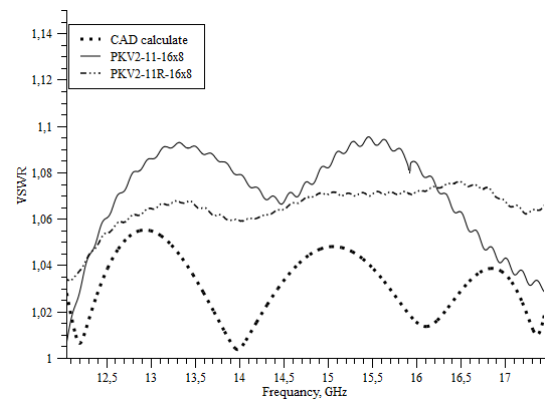
Fig. 6. Comparative graphs of VSWR measurement results of the prototype samples and calculated value for the waveguide cross section of 16х8